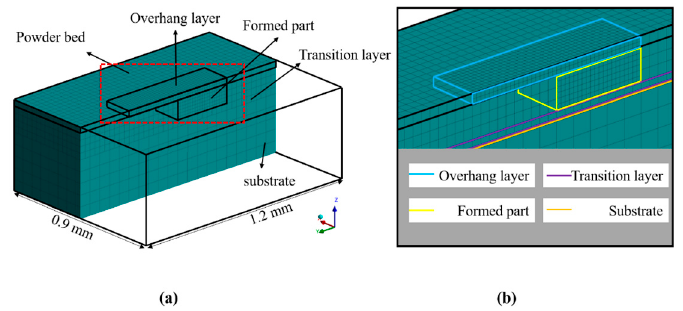
Figure 2. Finite element model: ( a ) model geometric information and ( b ) local amplification.